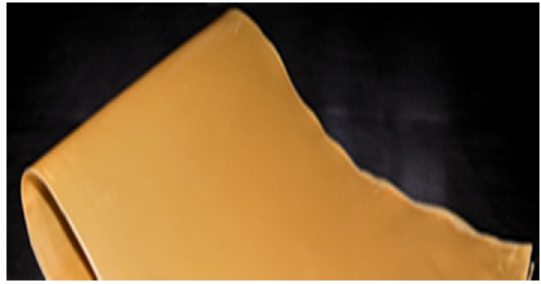
Figure 5. Bipolar MB-2 membrane anion-exchange membrane.